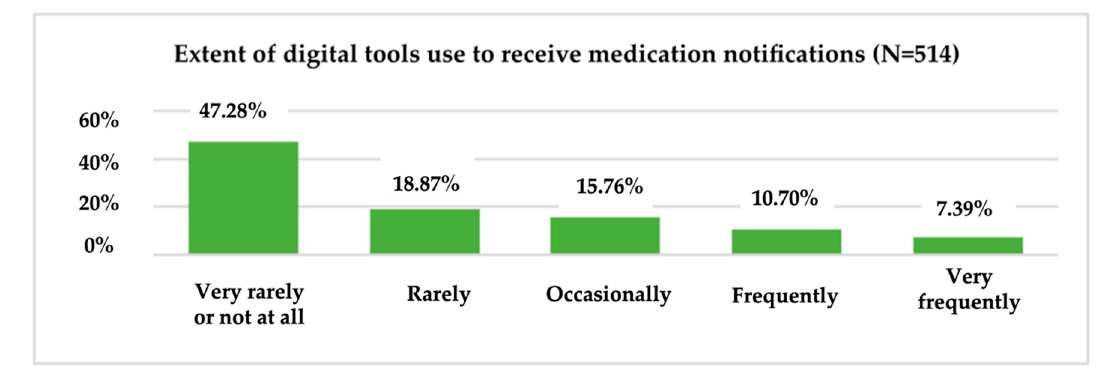
Figure 8. The use of digital tools to receive medication notifications.